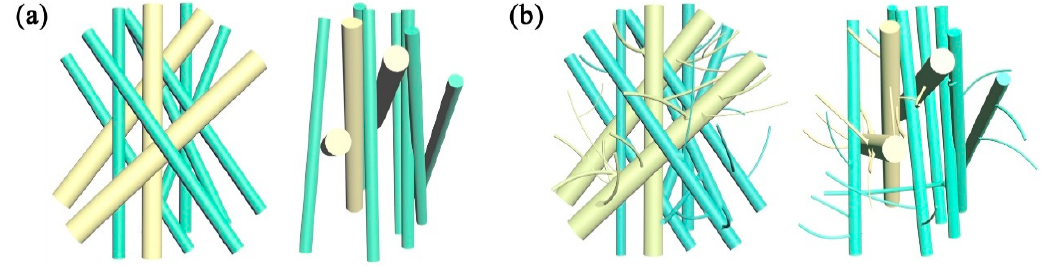
Figure 14. Main and left view schematic diagram of ( a ) PP and ( b ) PC-1.